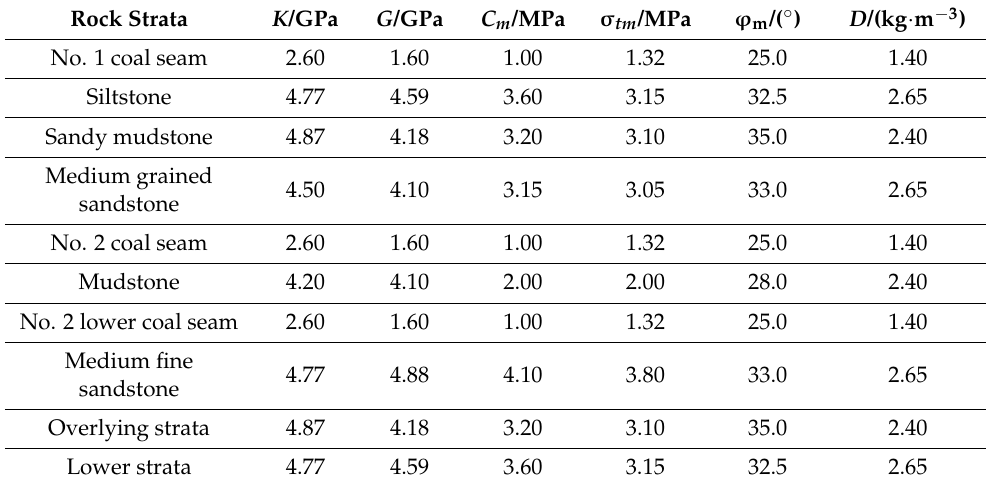
Table 2. Numerical simulation schemes.